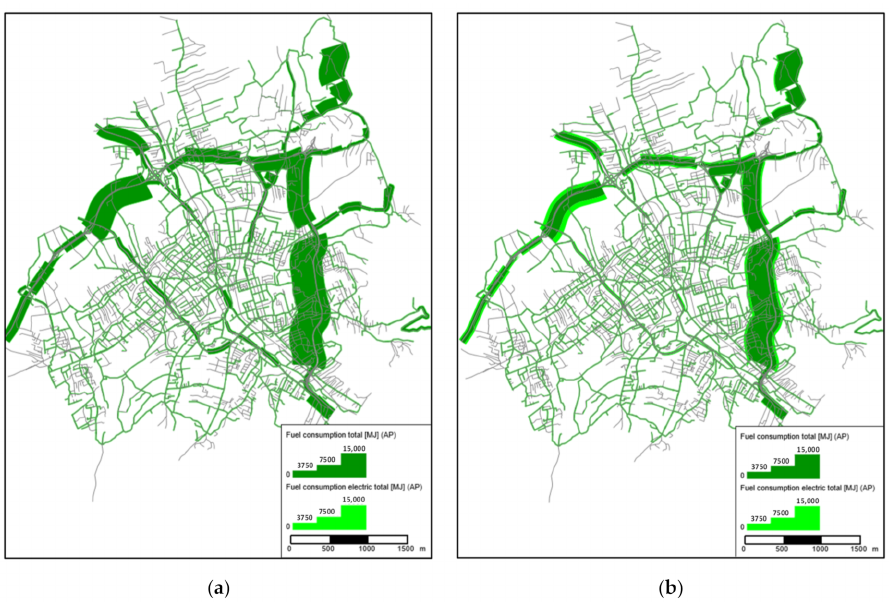
Figure 12. The assessment of fuel consumption total [MJ] and fuel consumption electric total [MJ] (measures from Group 2) for scenario W0 and optimal scenario (W4)—analysis for the whole city: ( a ) measures for scenario W0; ( b ) measures for scenario W4.